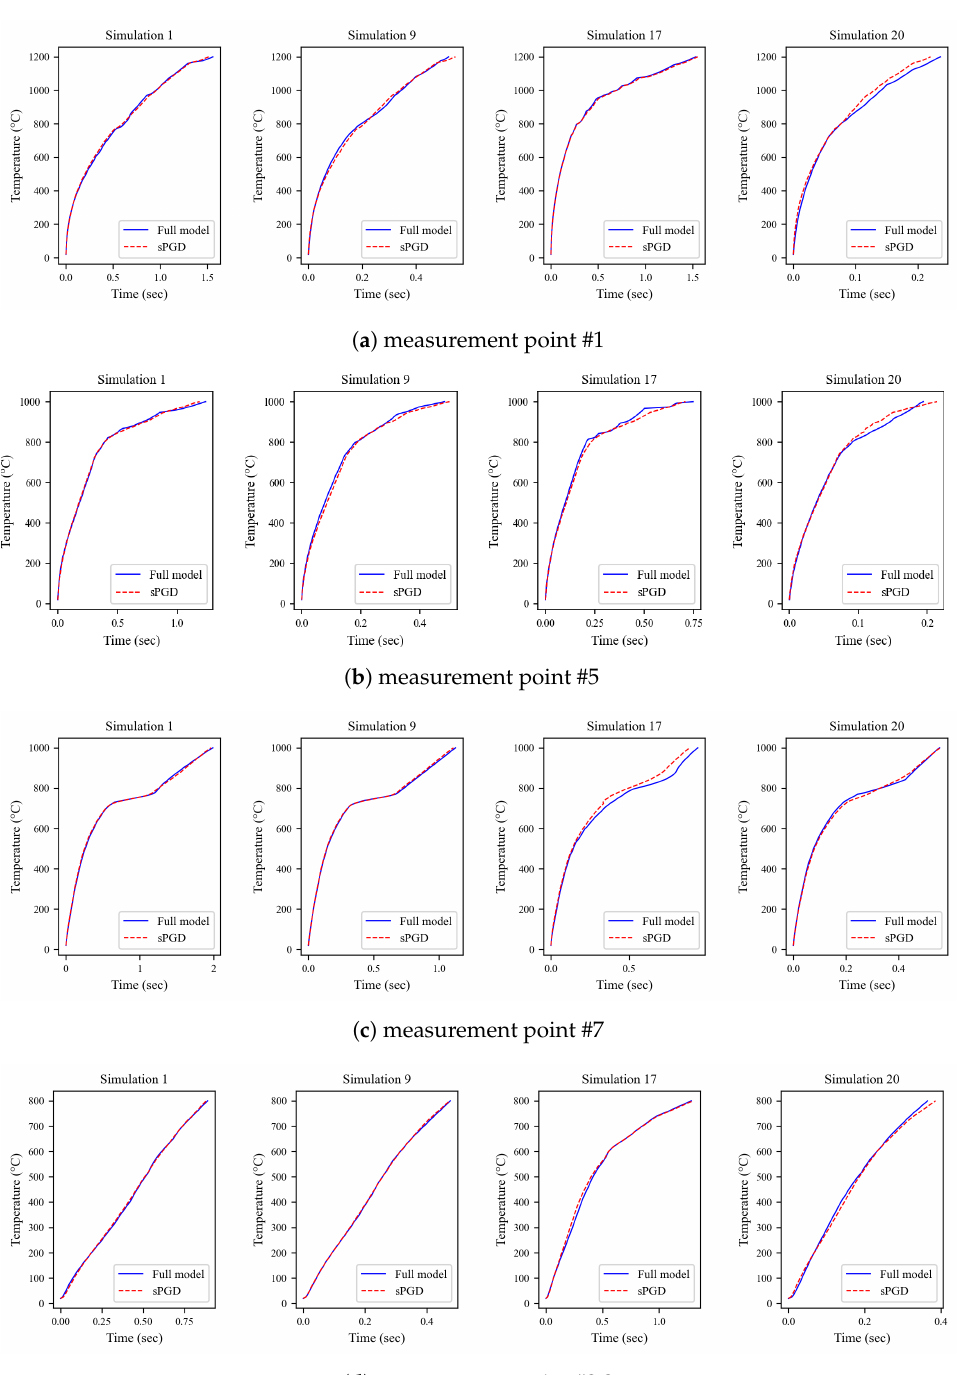
Figure 5. Comparison of the time evolution of temperature between the reference full model and the sPGD regression model (with the predicted values of modal coefficients) for 4 measurement points: simulations #1 and #9 are used to create the regression model and simulations #17 and #20 are used to check the regression model